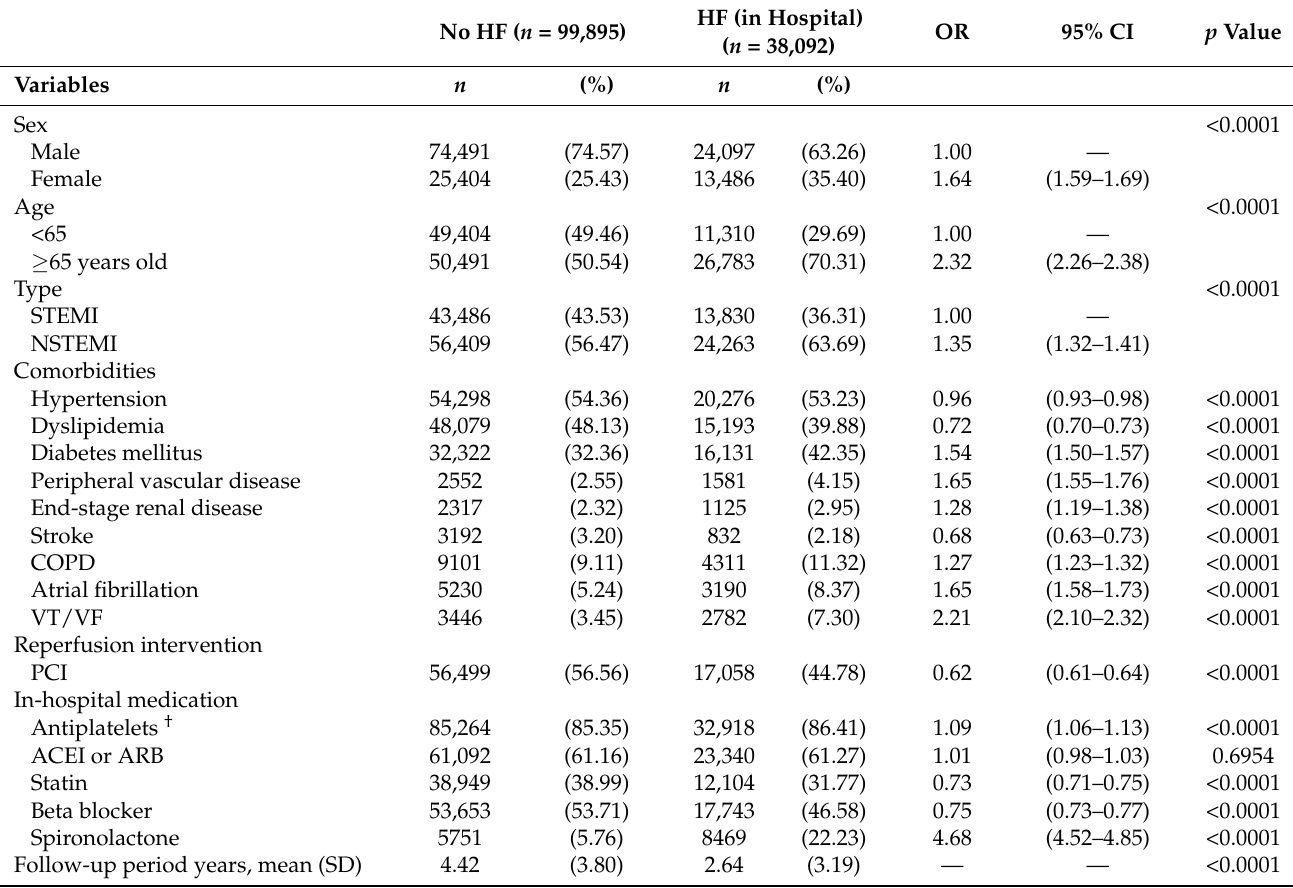
Table 1. Basic characteristics of AMI patients associated with or without (in hospital)